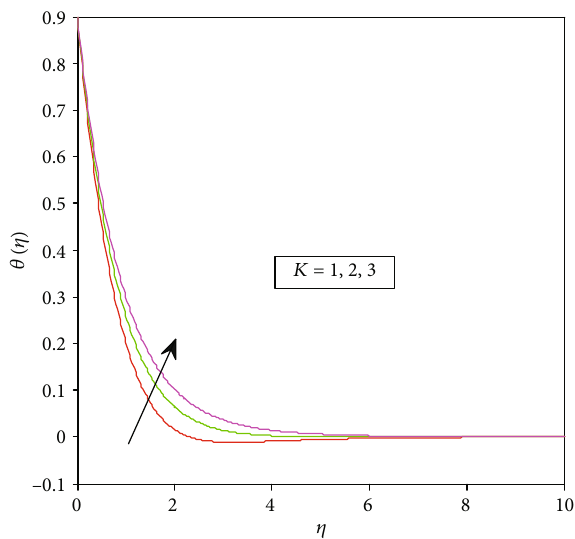
Figure 9: Temperature distribution for di ff erent values of the couple stress parameter.